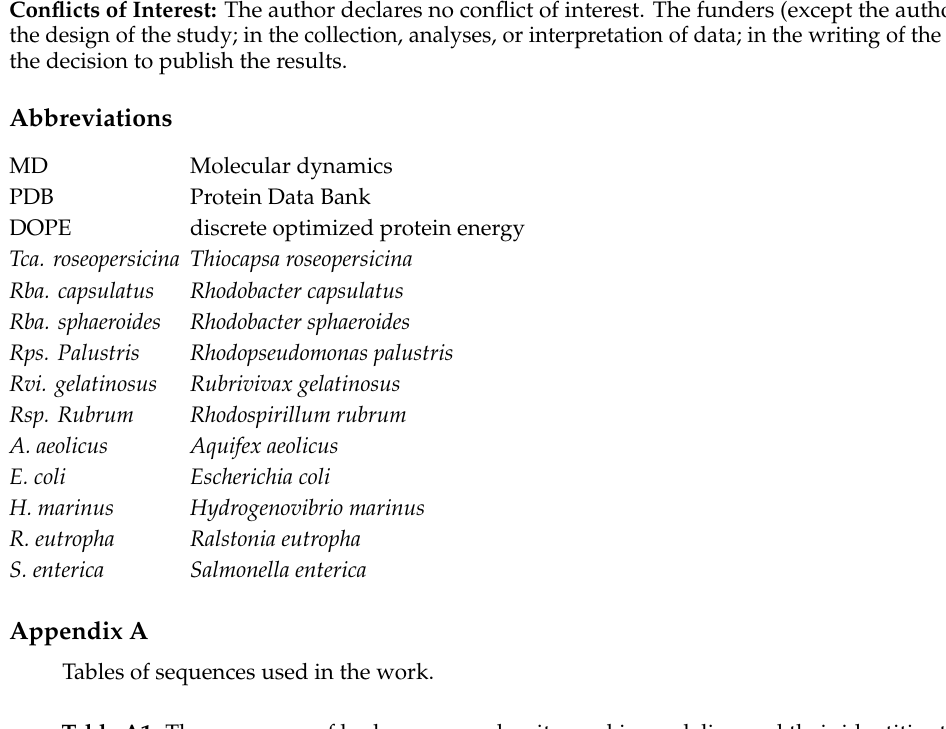
Table A1. The sequences of hydrogenase subunits used in modeling and their identities to templates from